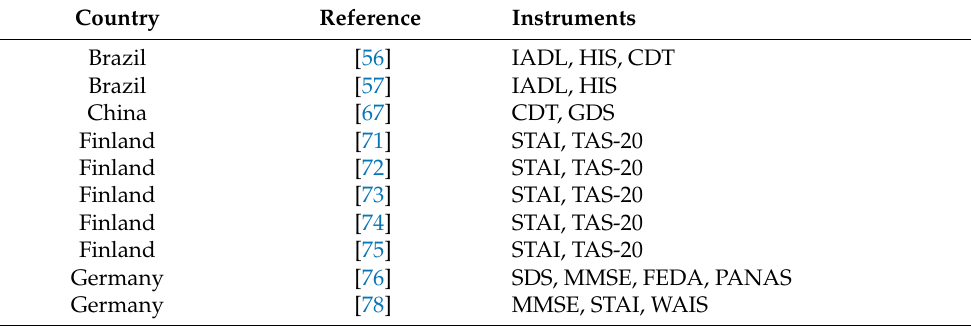
Table 3. Neuropsychological instruments used for participant evaluation in the reviewed articles. Abbreviations: 20-item Center for Epidemiologic Studies—Depression Scale (CES–D) [119],